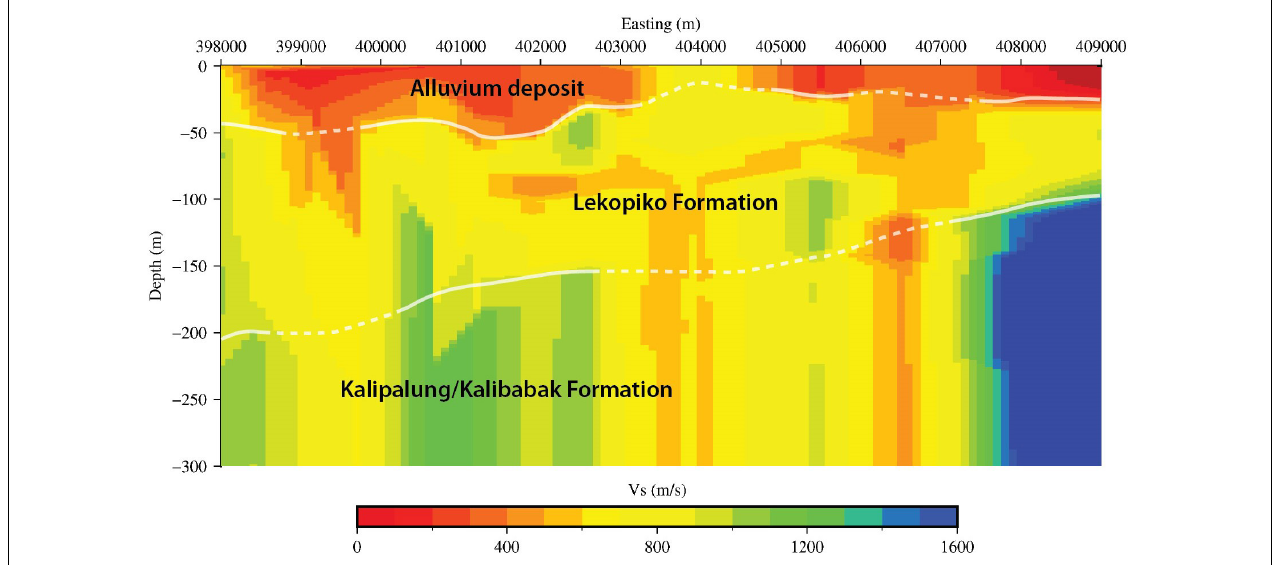
FIGURE 12 | Vertical cross-section of Vs structure from the result of the inversion process of HHT-HVSR curves with a larger extent and deeper depth than that of Figure 10C along with the interpretation of the vertical